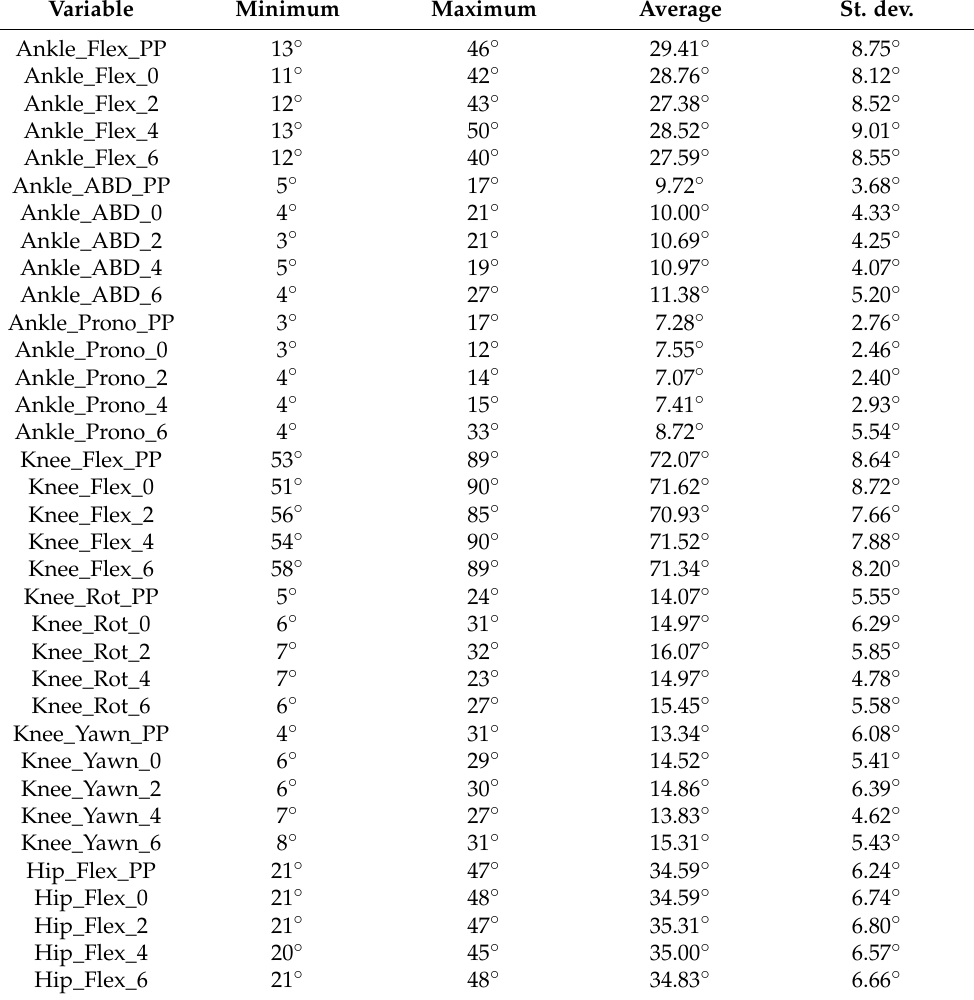
Table 1. Descriptive statistics. Ankle flex: ankle flexion; Ankle_ABD: ankle abduction; Knee_flex: knee flexion; knee_rot: knee rotation; knee_yawn: knee varus/valgus; Hip_flex: hip flexion; Hip_rot: hip rotation; Hip_ABD: hip abduction; Pelvis_AP: pelvis front-back; Pelvis_Rot: pelvis rotation; Pelvis_ML: pelvis mid-lateral; AVG: